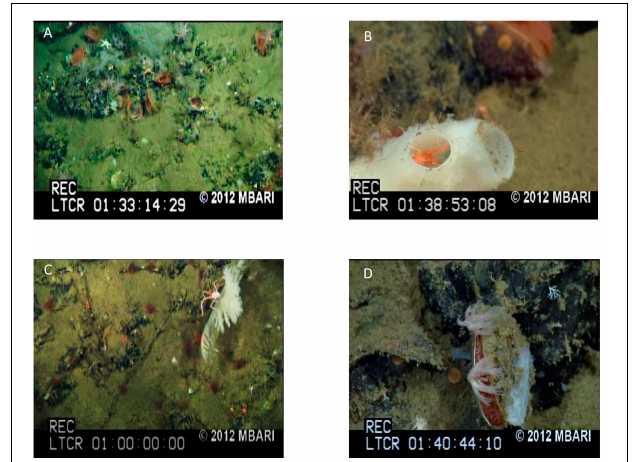
FIGURE 4 | Seafloor images showing sub-habitats identified during the transects performed between 849 and 990 m depth in Dive D347 in the NW limit of Guaymas Basin and the Sonoran Margin within the oxygen minimum zone (OMZ). (A) Soft sediments in the lower OMZ boundary dominated by the elasipodid holothurian of the genus Pannychia , some benthopelagic fish and burrows. (B) Tubular sponges in unconsolidated sediments in the lower OMZ boundary. (C) Small rocky outcrops colonized by anemones and sponges in the lower OMZ transitional zone to the lower OMZ boundary. (D) Large rocky outcrops ( > 30 cm) in the lower OMZ transitional zone to the lower OMZ boundary that provide refuge for small decapod crustacean. Images courtesy of MBARI.